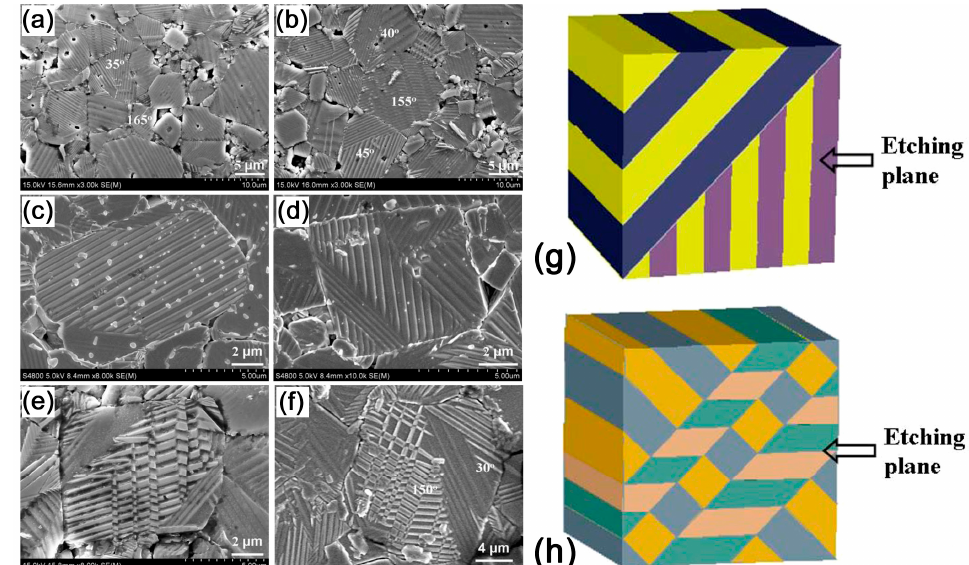
Figure 3. SEM images of domain patterns for the poled NaNbO 3 (KNN) ceramics. The magnifications are ( a , b ) ×3000; ( c , e ) ×8000; ( d ) ×10,000 respectively; ( f ) The partially enlarged view of SEM image. Models of domain configurations with the front planes as the observation planes: ( g ) Model for domain configuration type I; and ( h ) for domain configuration type II. The grains with domain configuration type I are in ( c , d ), grains with domain configuration type II are in ( e , f ). Adapted from [67], with permission from © 2013 AIP Publishing LLC.